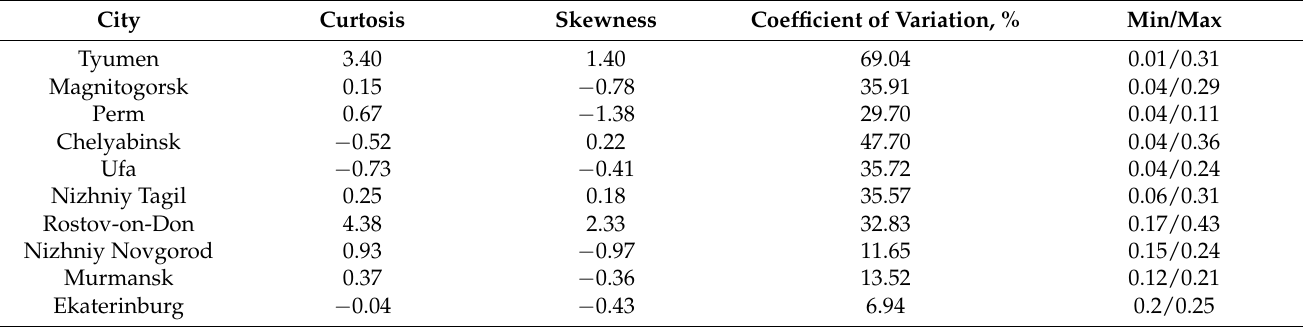
Table 4. The additional parameters of distribution of the proportion of technogenic particles in particle size fraction of 0.1–1 mm in